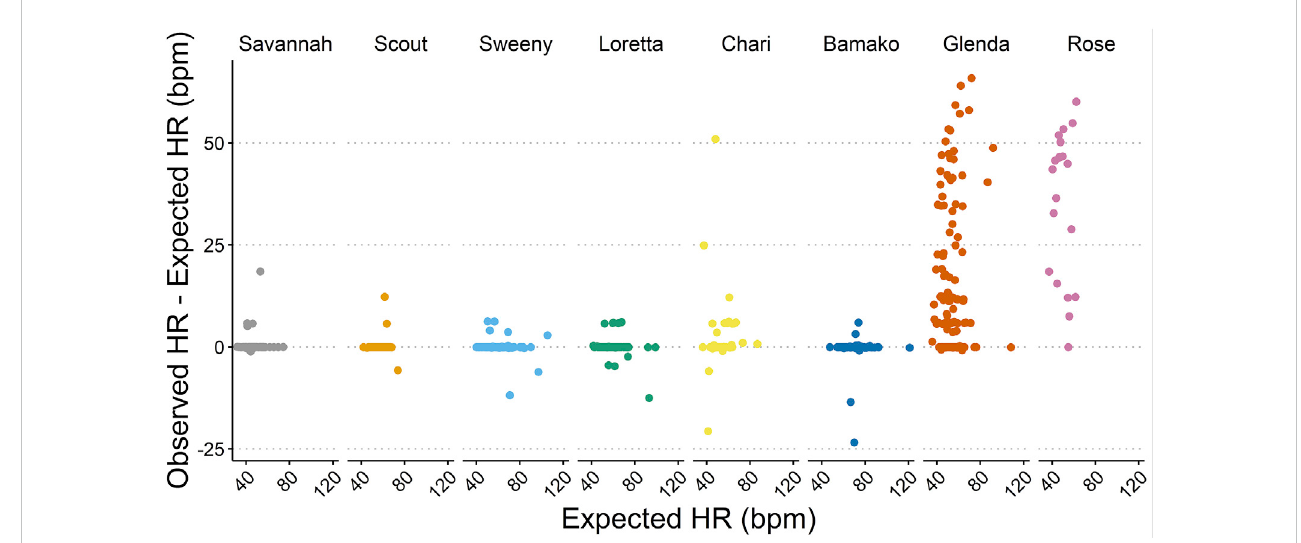
FIGURE 3 Accuracy of the heart rate (HR) measurements based on the absolute difference (bpm) between observed HR (detected by the biologger) and expected HR (con fi rmed by ECG validation).